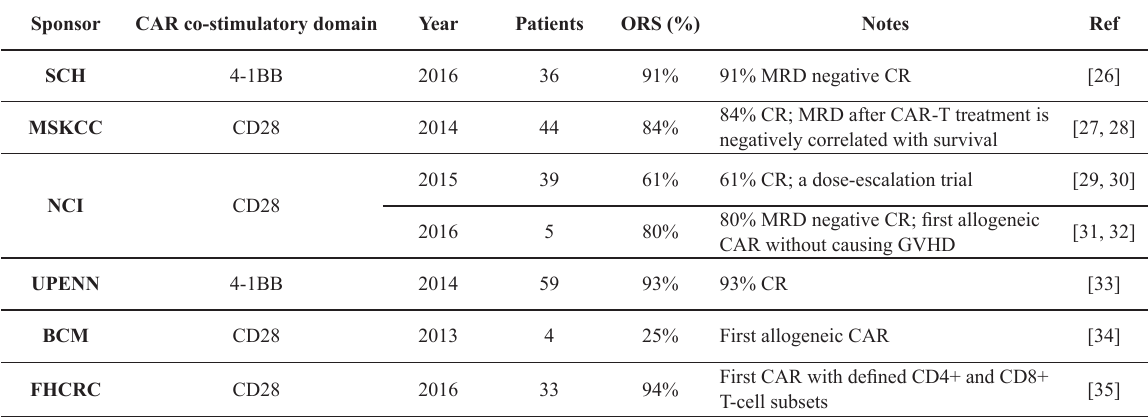
Table 1: The clinical result of CD19 CAR-T in B cell leukemia.